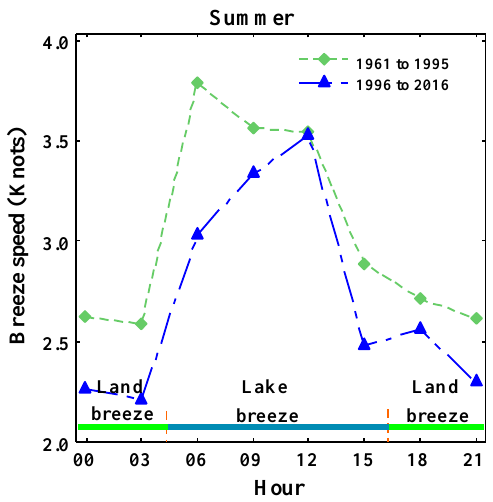
Figure 9. Speed of summer lake and land breezes at Urmia meteorological station in sub-periods with normal (1961–1995) and low level (1996–2016) in Lake Urmia.